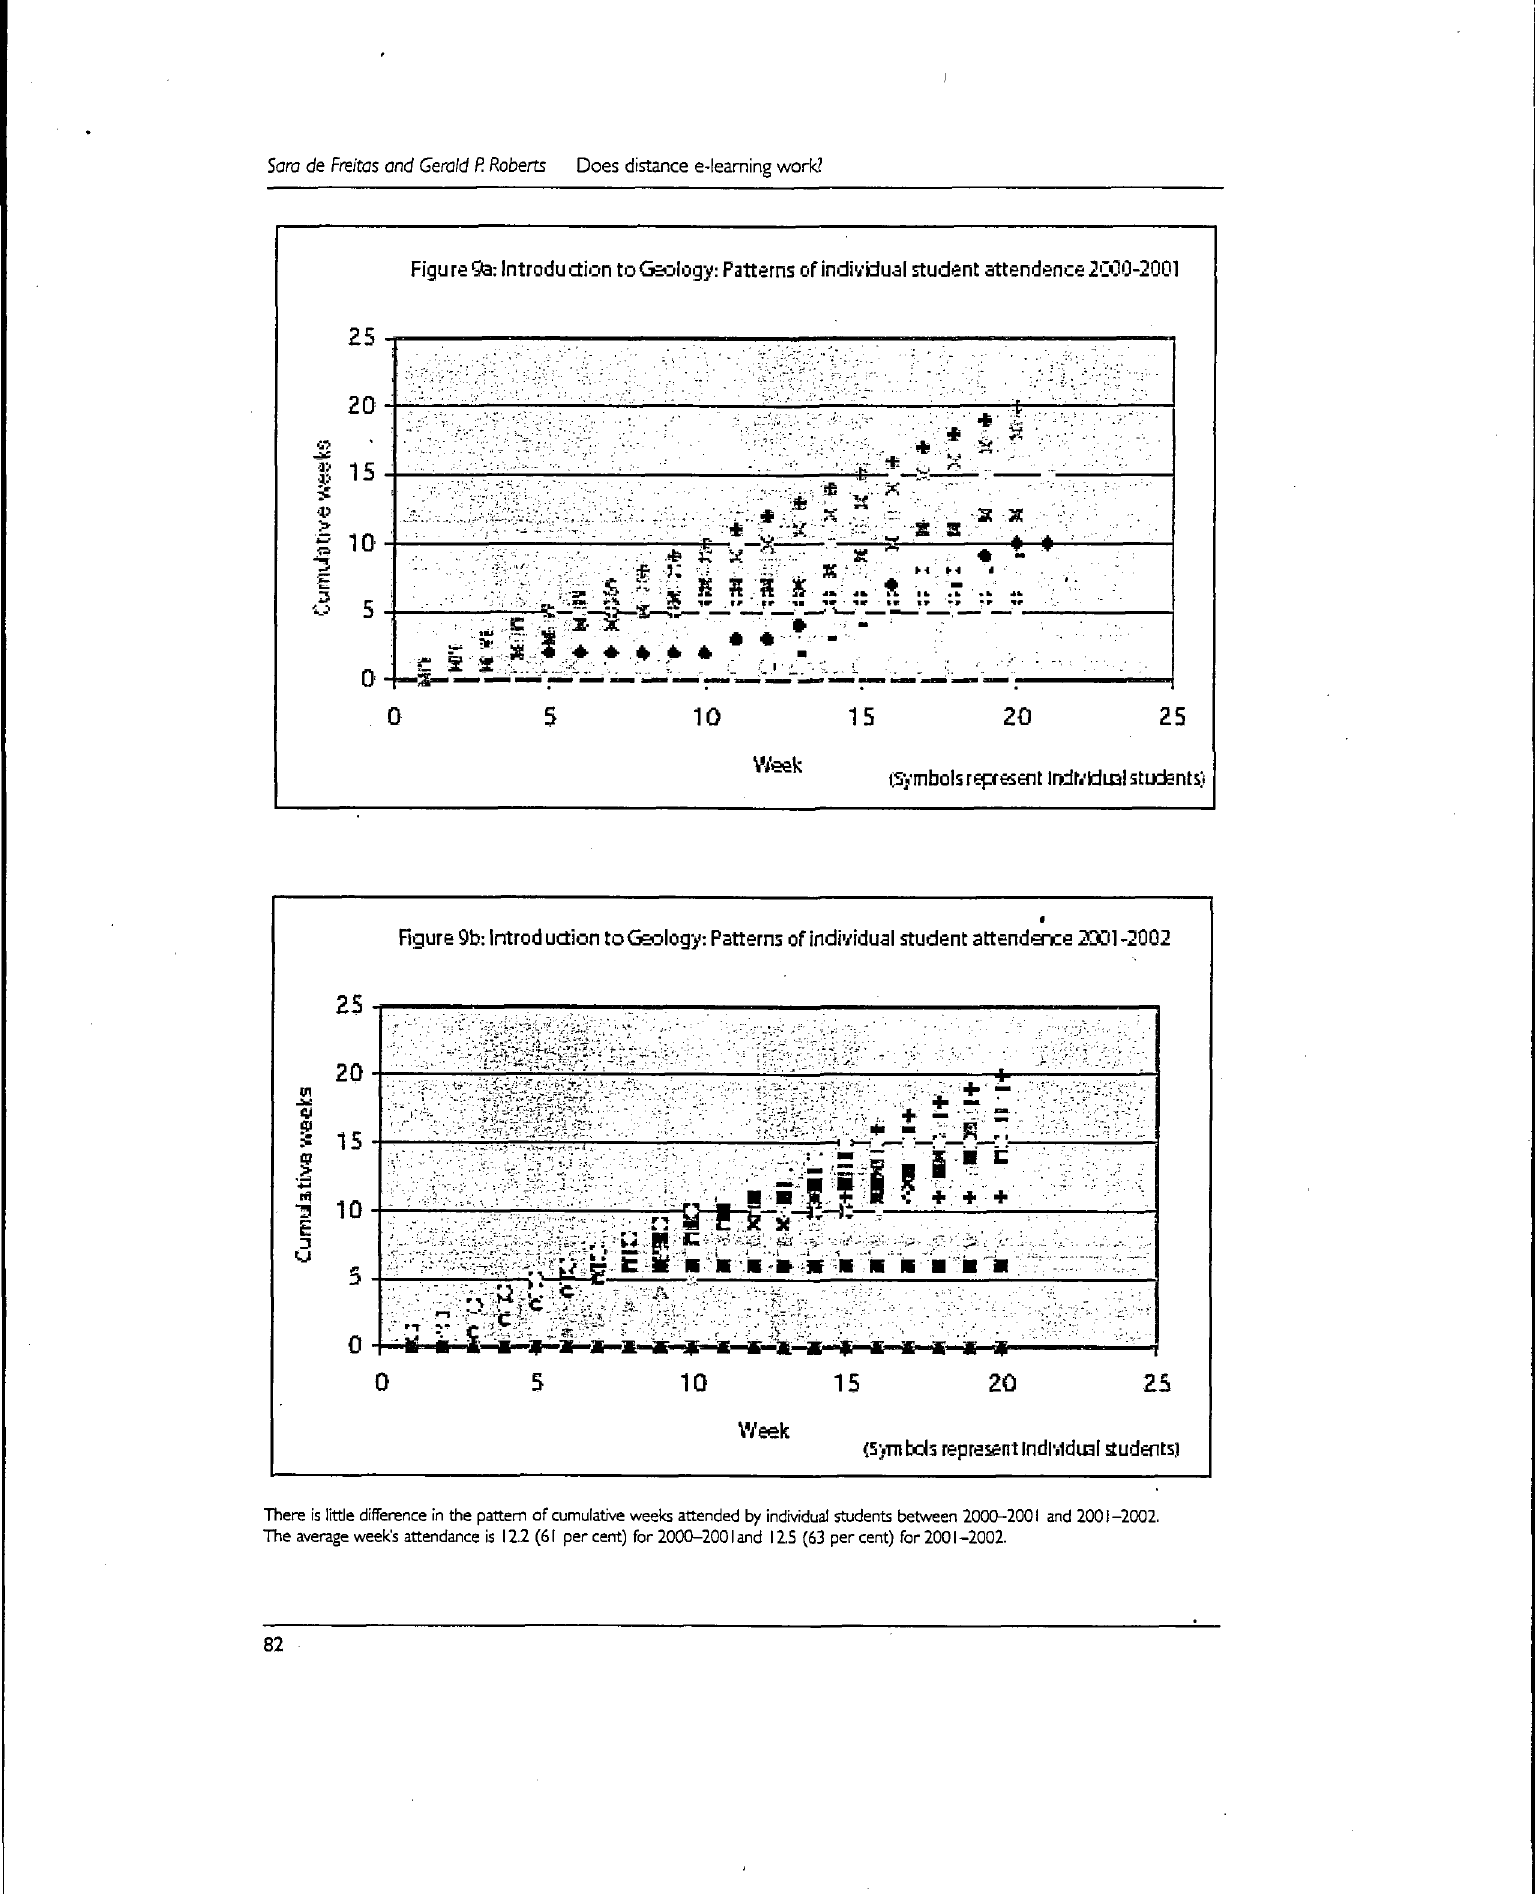
Figure 9b: Introduction to Geology: Patterns of individual student attendance